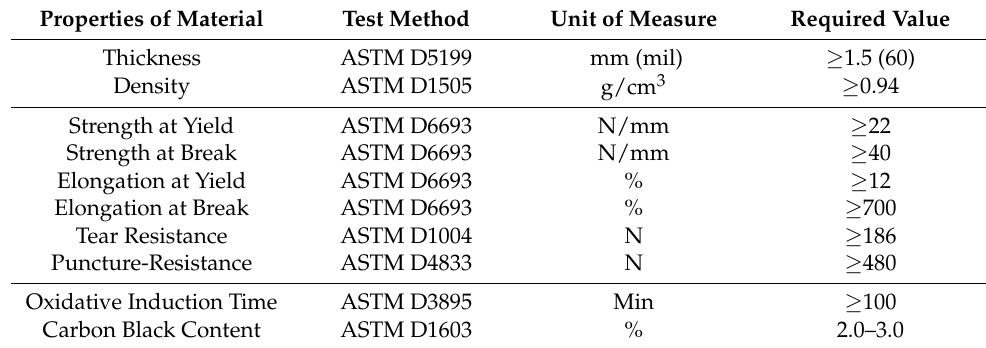
Table 3. HDPE smooth-textured, black-colored geomembrane properties [29–37].